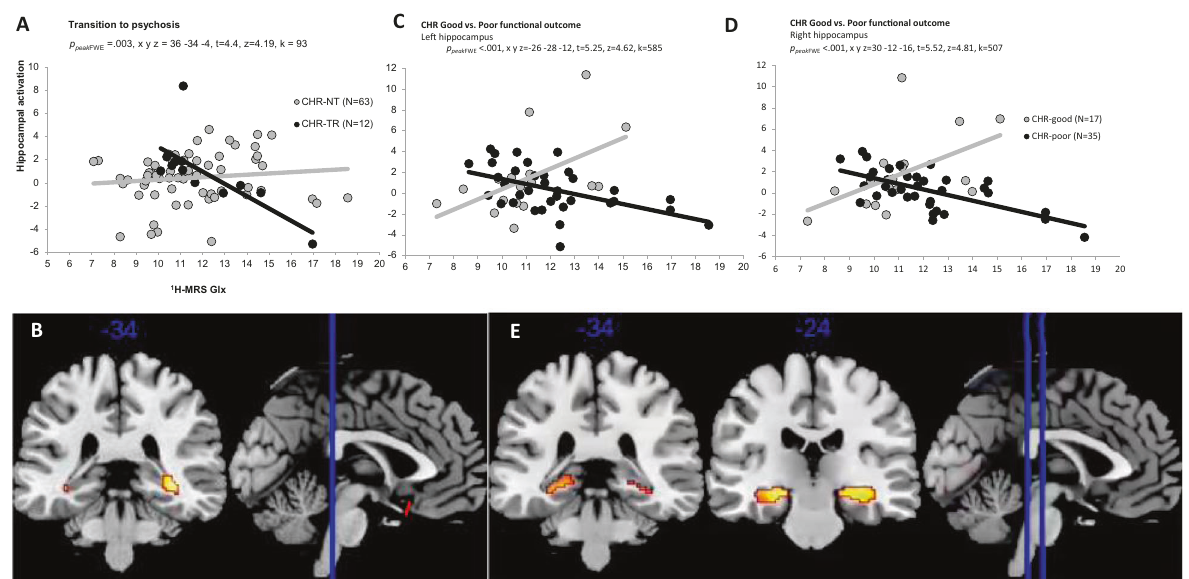
Fig. 2 Functional activity. A Scatterplot showing interaction between Group (CHR-T vs. CHR-NT) x hippocampal Glx on right hippocampal activation during novel > neutral oddball trials. B SPM brain map (coronal section) showing right hippocampal activation for Group (CHR-T vs. CHR-NT) x hippocampal Glx during novel > neutral oddball trials (P FWE < .017). C and D Scatterplots showing interaction between Group (CHR-poor vs. CHT-good) x hippocampal Glx on bilateral hippocampal activation during novel > neutral oddball trials. E) SPM brain map (coronal section) showing bilateral hippocampal activation for Group (CHR-good vs. CHR-poor) x hippocampal Glx on novel > neutral oddball trials (pFWE < CHR-NT and HC groups, we compared parameter estimates for hippocampal fMRI activation during the main effect of the task, which were similar (HC SD = 2.81, CHR-NT SD 2.87, CHR-T SD = 1.88).